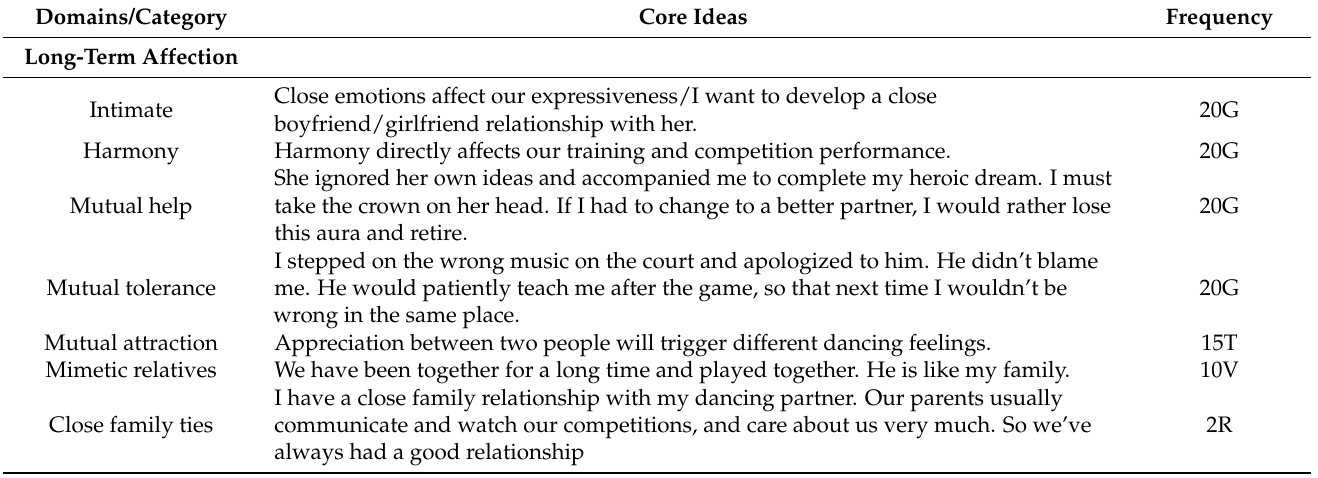
Table 4. Domains and